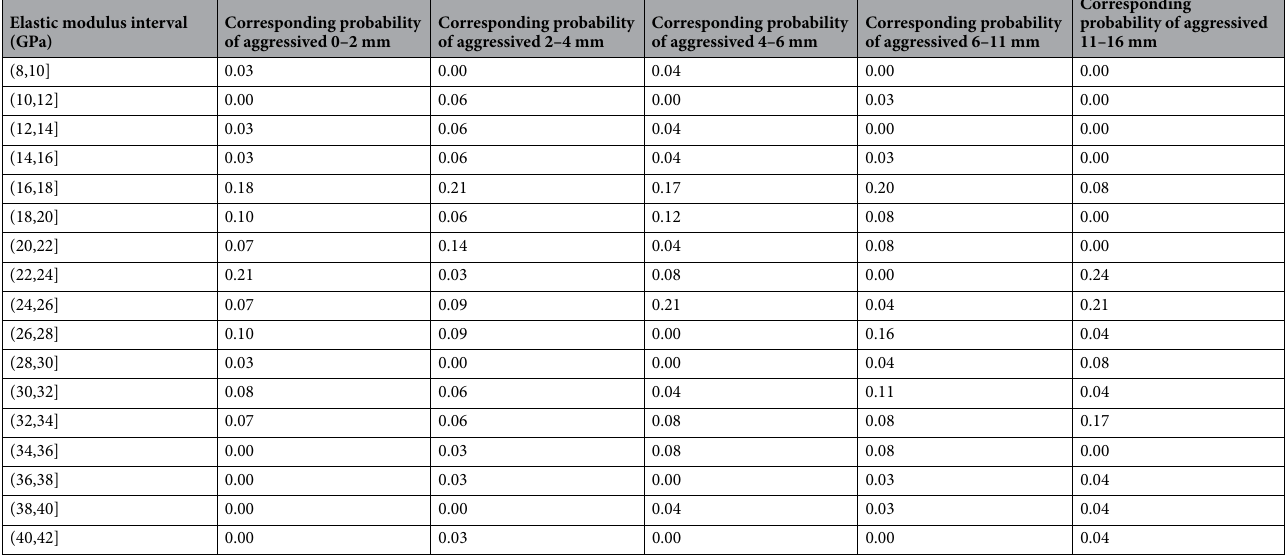
Table 6. Probability distribution of the elastic modulus at different aggressived depths for group